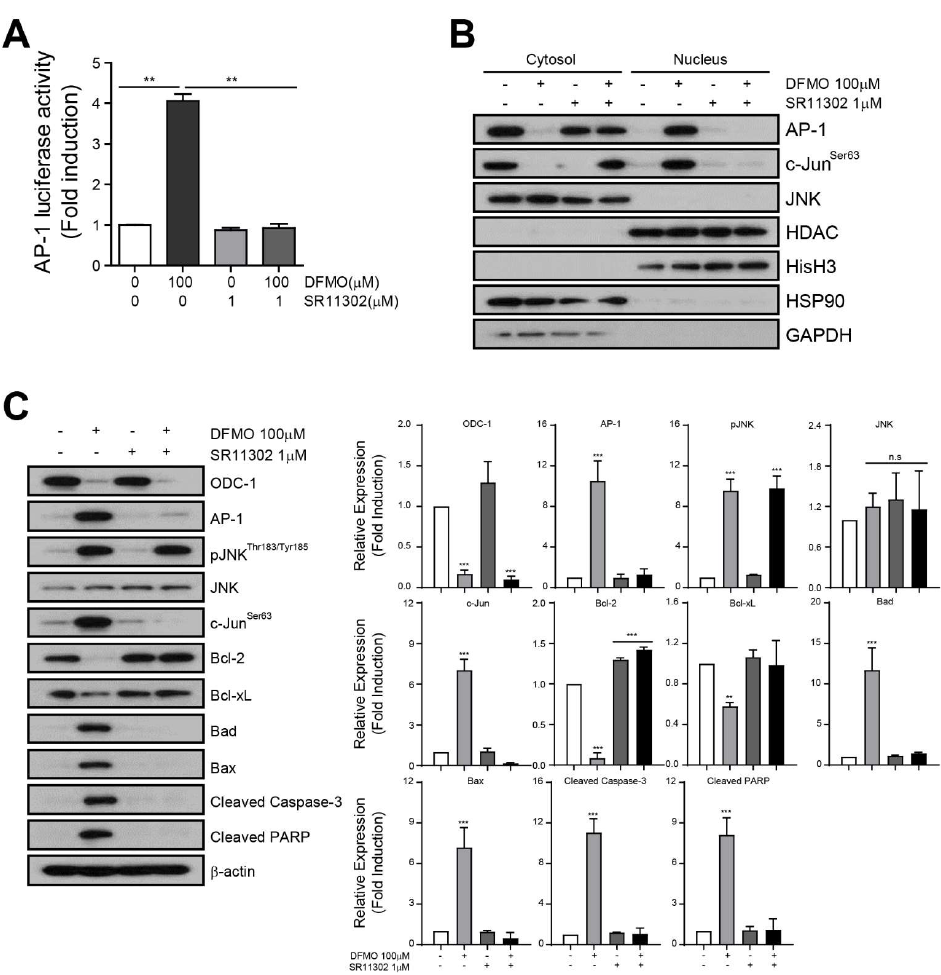
Figure 5. Induction of DFMO-induced apoptotic cell death through the regulation of AP-1 activity. The transfected cells were seeded in cell culture plates and treated with DFMO, SR11302, or DFMO/SR11302 for 48 h. ( A ) The AP-1 luciferase activity in the treated cells was determined using the Luciferase Assay System. ( B ) Western blot of organelle extracts (10 µg) was performed using the following markers: nucleus; HDAC, Histone H3/ cytosol: Hsp90, GAPDH. ( C ) Western blot analysis of the JNK signaling pathway detected JNK signaling proteins (phospho-JNK, JNK, phospho-cJun, AP-1), anti-apoptotic proteins (Bcl-2, Bcl-xL), and proapoptotic proteins (Bad, Bax cleaved caspase- 3, cleaved PARP) in DFMO-, SR11302-, or DFMO/SR11302-treated cells, respectively. The controls were treated with 0.1% DMSO. Data are expressed as mean ± SD. * p < 0.05, ** p < 0.01, *** p < 0.001 compared with the controls. 3. Discussion